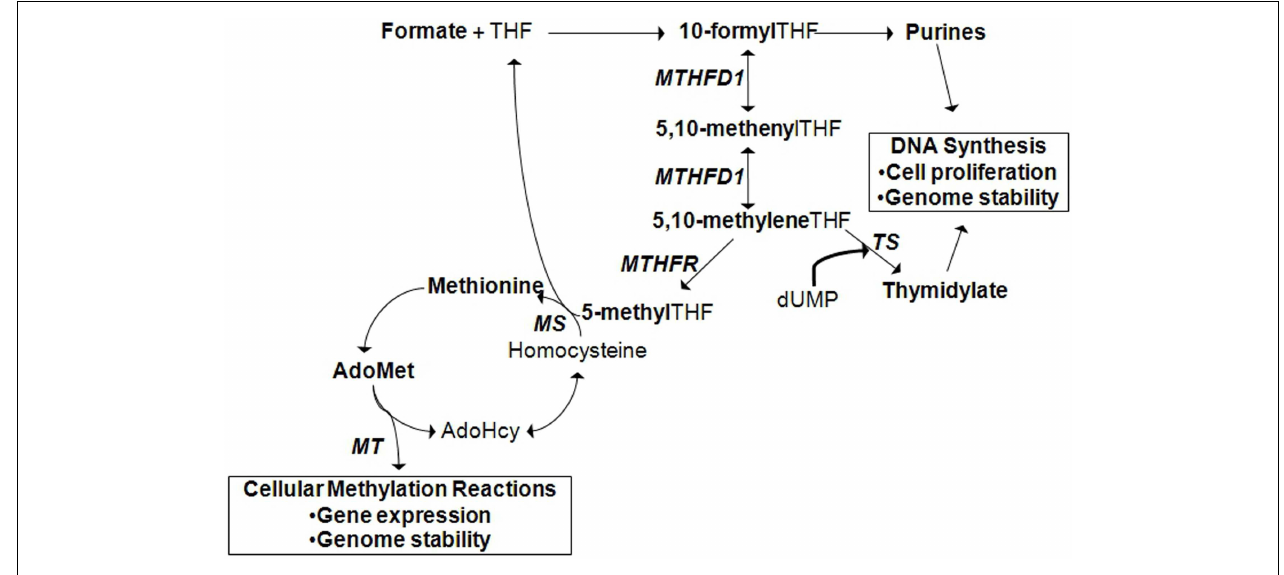
homocysteine can also be remethylated by betaine:homocysteine methyltransferase (BHMT), a reaction that depends on choline-derived betaine as the methyl donor (not shown). Methionine is converted to AdoMet, from which methyltransferases (MT) transfer methyl groups to acceptor molecules. Acceptor molecules include DNA, RNA, histones and other proteins, and other small molecules.The reaction produces S -adenosylhomocysteine (AdoHcy) that can be converted to homocysteine. TS, thymidylate synthase; MTHFD1, methyleneTHF dehydrogenase